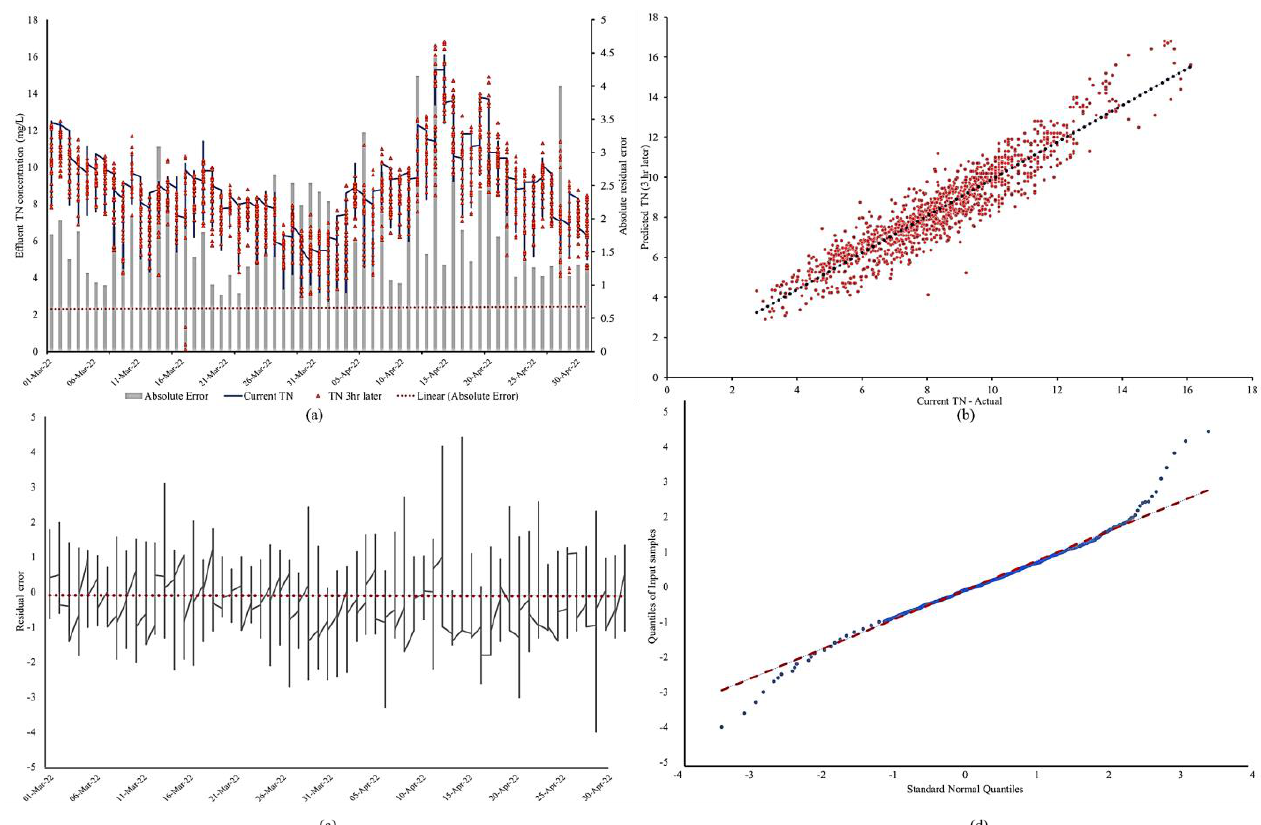
Figure 11. Three-hour ahead prediction performance visualization of ( a ) a time series of predicted effluent TN, ( b ) a scatter plot of predicted and current TN values, ( c ) the generated residuals, and ( d ) the quantile – quantile plot for model residuals.